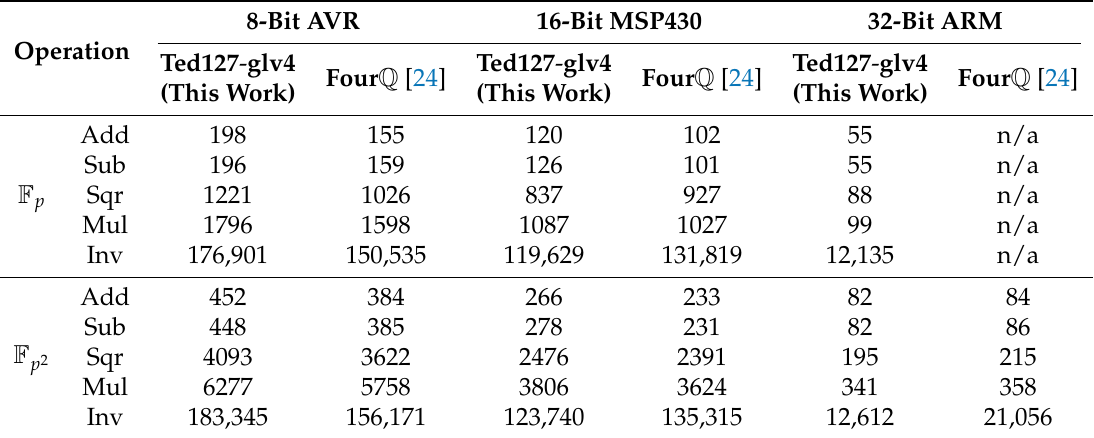
Table 3. Cycle counts for field arithmetic on 8-bit AVR, 16-bit MSP430, and 32-bit ARM processors, including function call